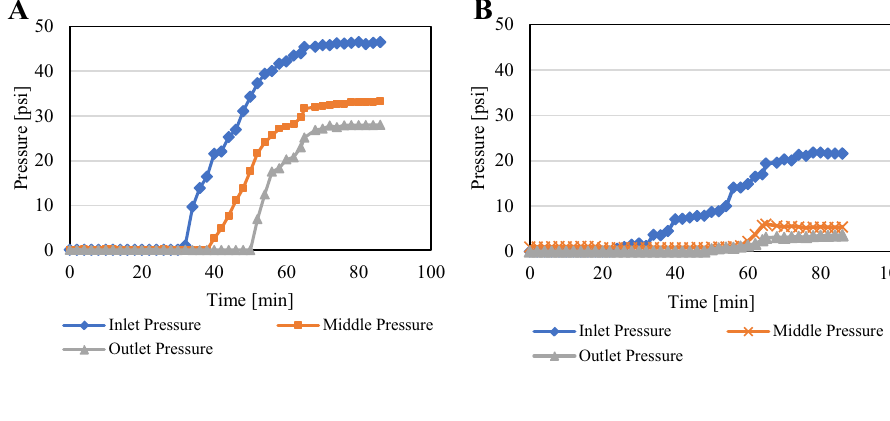
Fig. 6 Gel propagation through fractures: (I) gel particle size to fracture width ratio is 1.5 and (II) gel particle size to fracture width ratio is